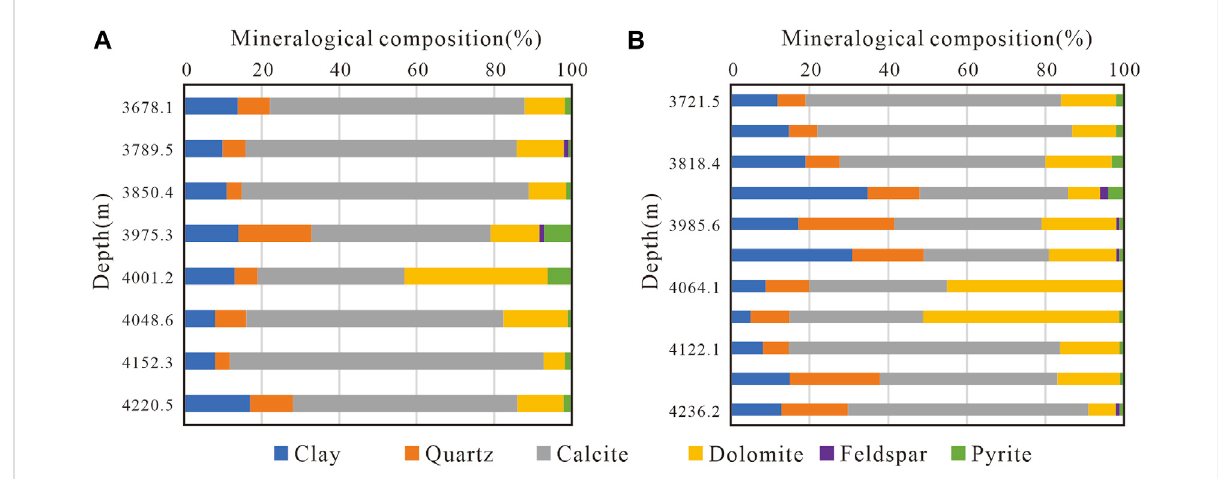
FIGURE 4 Bar chart of mineral components in marl reservoir: (A) mineral composition of the laminated marl reservoir; (B) mineral composition of the massive marl reservoir.